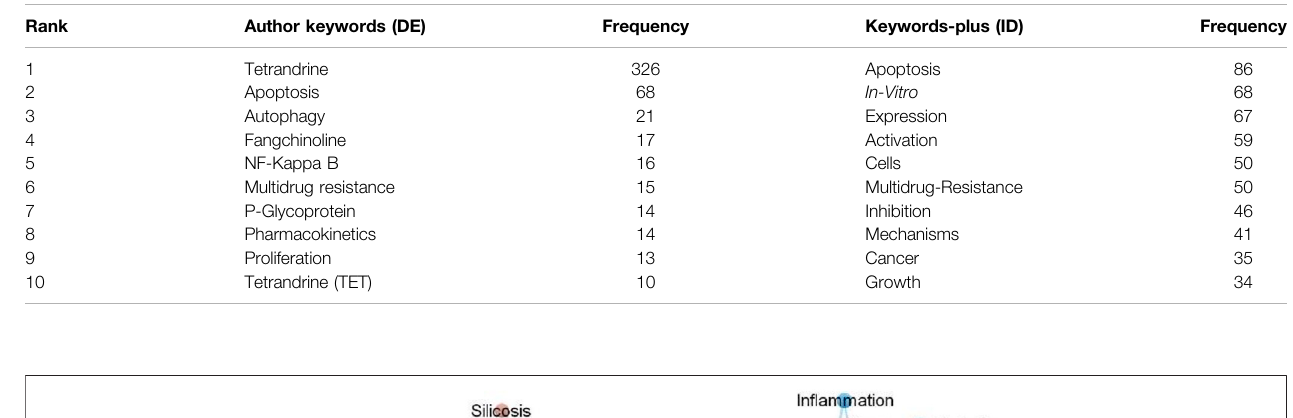
Frontiers in Pharmacology |